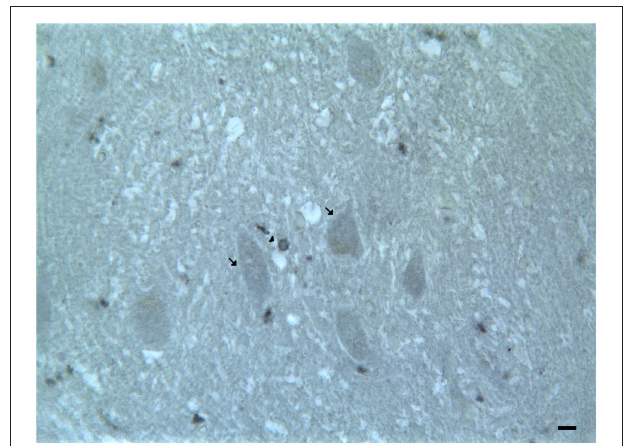
FIGURE 4 | Dopamine receptor type 2 (DRD 2 ) immunoreactivity in the dentate nucleus. The (DRD 2 ) immunoreactivity is detectable in the dentate nucleus gray substance and in the neighboring withe substance; DRD 2 immunoreactive small neuron cell bodies (arrowheads); DRD 2 immunoreactive cell body of projective neuron type, central neuron (arrow); diffuse DAT immunoreactivity in the neuropil of the nucleus (Scale bar: 15 µ m).